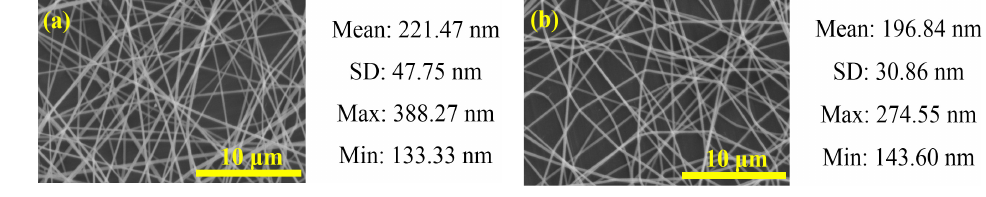
Figure 5. Cont. Figure 5.